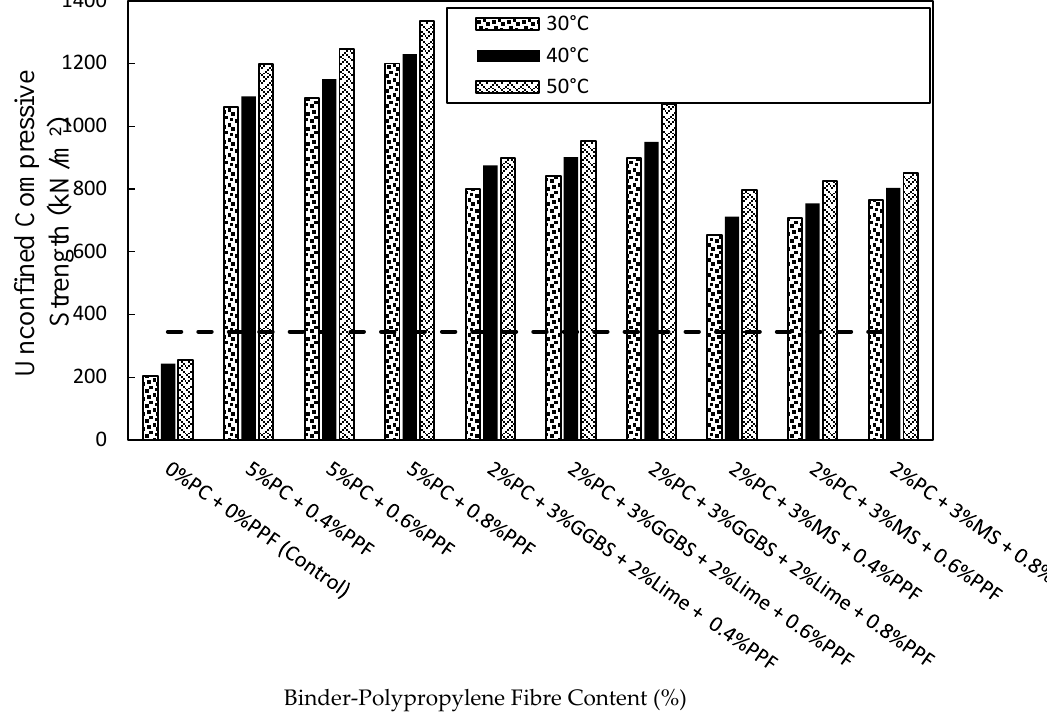
Figure 6. UCS of polypropylene-reinforced clay-binder mixtures tested after 24 h cooling period.